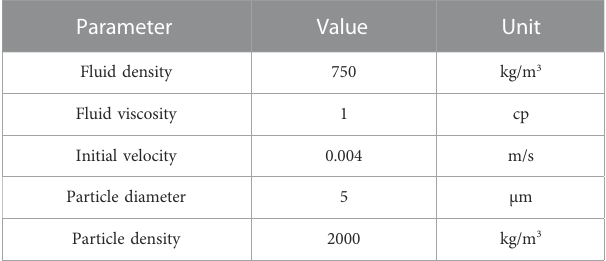
TABLE 1 Simulation inputs for the straight-tube model.